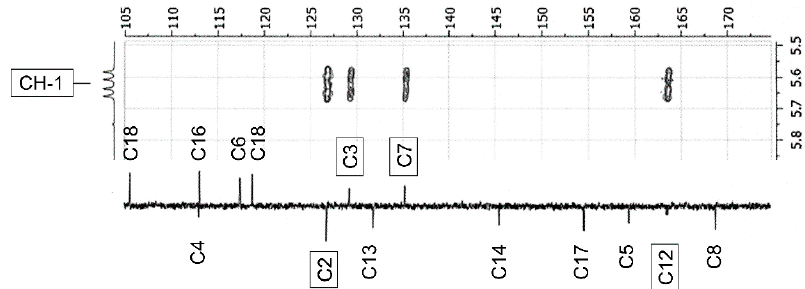
Figure 6. Partial spectra of heteronuclear multiple-bond correlation (HMBC) experiment showing four